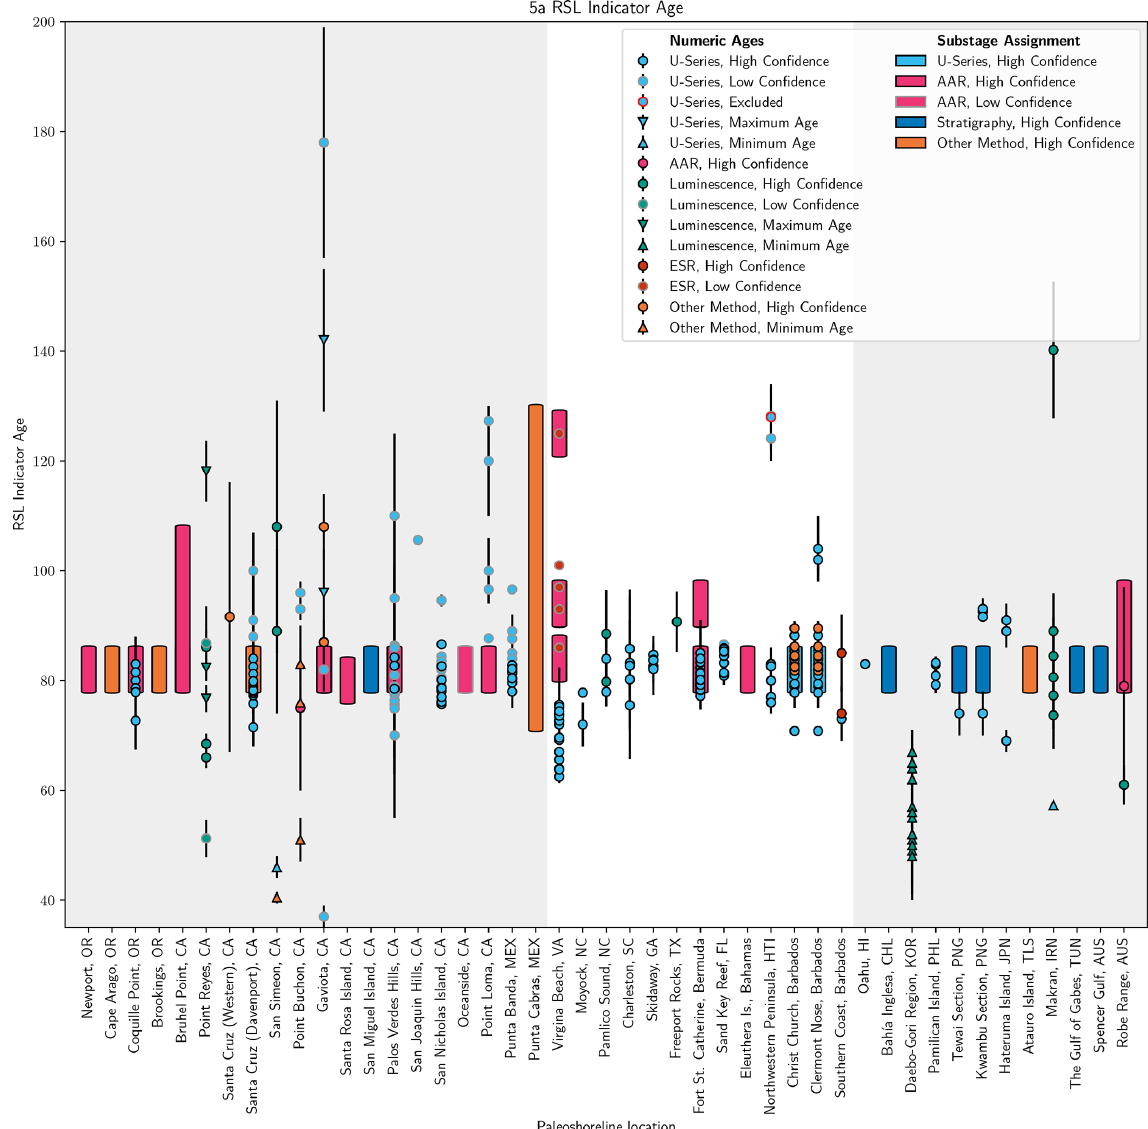
Figure 4. Age assignments for MIS 5a RSL indicators cropping out at the locations listed on the horizontal axis. For each location, the geochronological method is indicated by color; numeric, minimum, and maximum age type by shape; and the confidence of the age by border color. Symbols represent numerical ages, whereas, in the absence of a numeric chronology, bars represent general marine isotope substage assignments (MIS 5c 98–90ka, MIS 5a